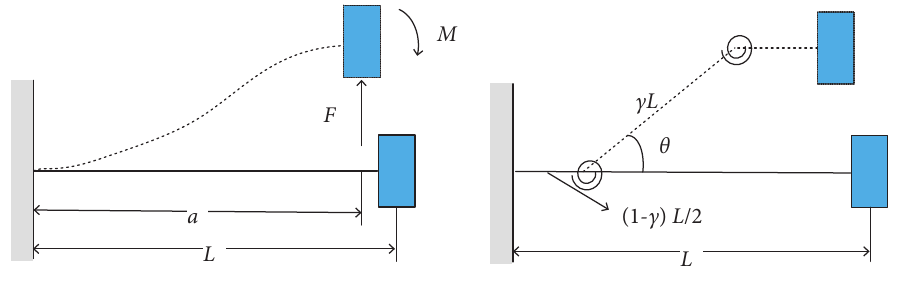
Figure 3. The deformation of fixed-oriented beam.